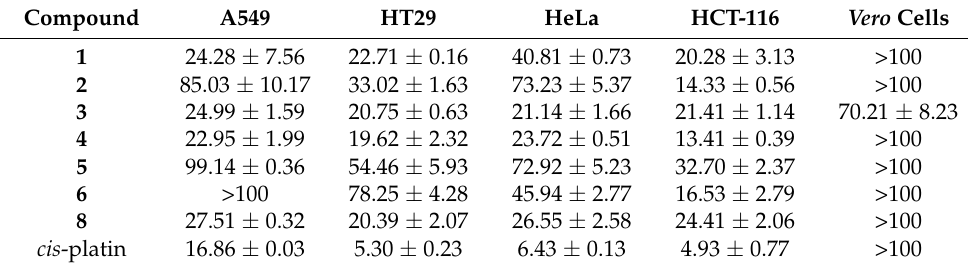
Table 3. Anti-proliferative activities of compounds 1 – 8 (IC 50 µ M).